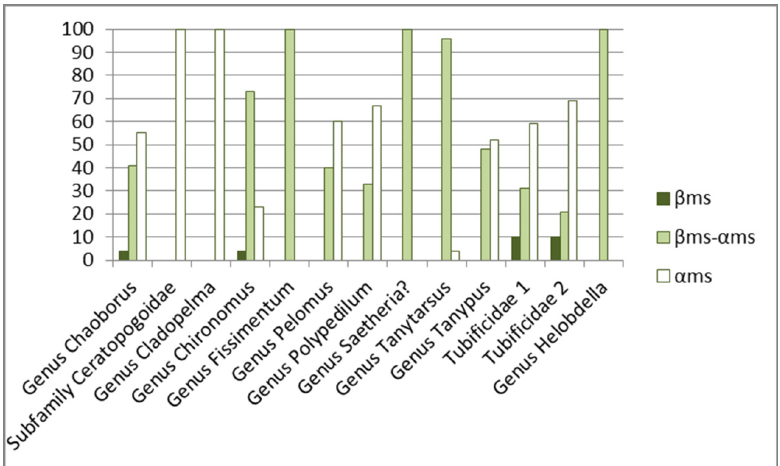
Figure 4. Frequency of occurrence of identified organisms of benthic macroinvertebrates according to saprobiotic levels for autumn/winter